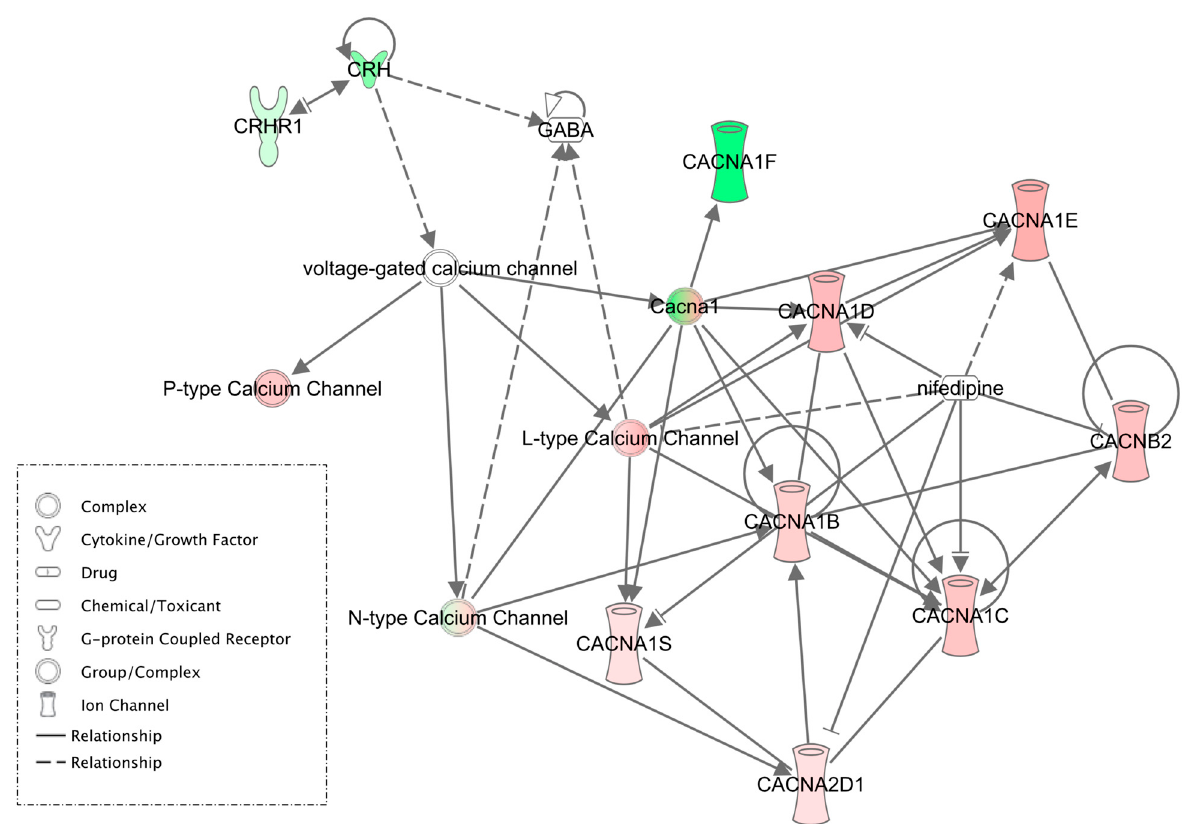
Figure 4. IPA-based molecular network showing literature-based relationships among calcium channels, CRF, and GABA. Corticotropin-releasing hormone ( Crh ) as well as L-type calcium channels, Cacna1f (Cav1.4) and Cacna1d (Cav1.3) were differentially expressed between CIE and control animals. Another CRF system-related DEG, Crhbp is not shown (see text for detail). Green color = down-regulation and red color = up-regulation in the CIE group, compared to control. These changes serve as molecular correlates of alcohol-induced cellular and behavioral effects mediated by CeA ([5]).